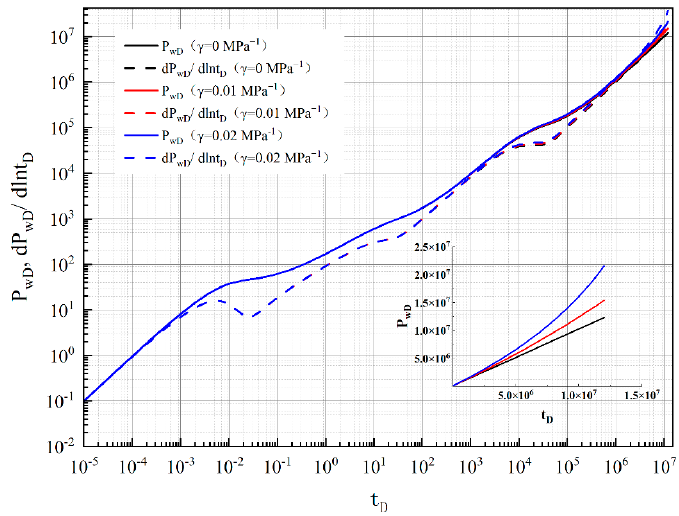
Figure 8. The effect of stress sensitivity on the pressure